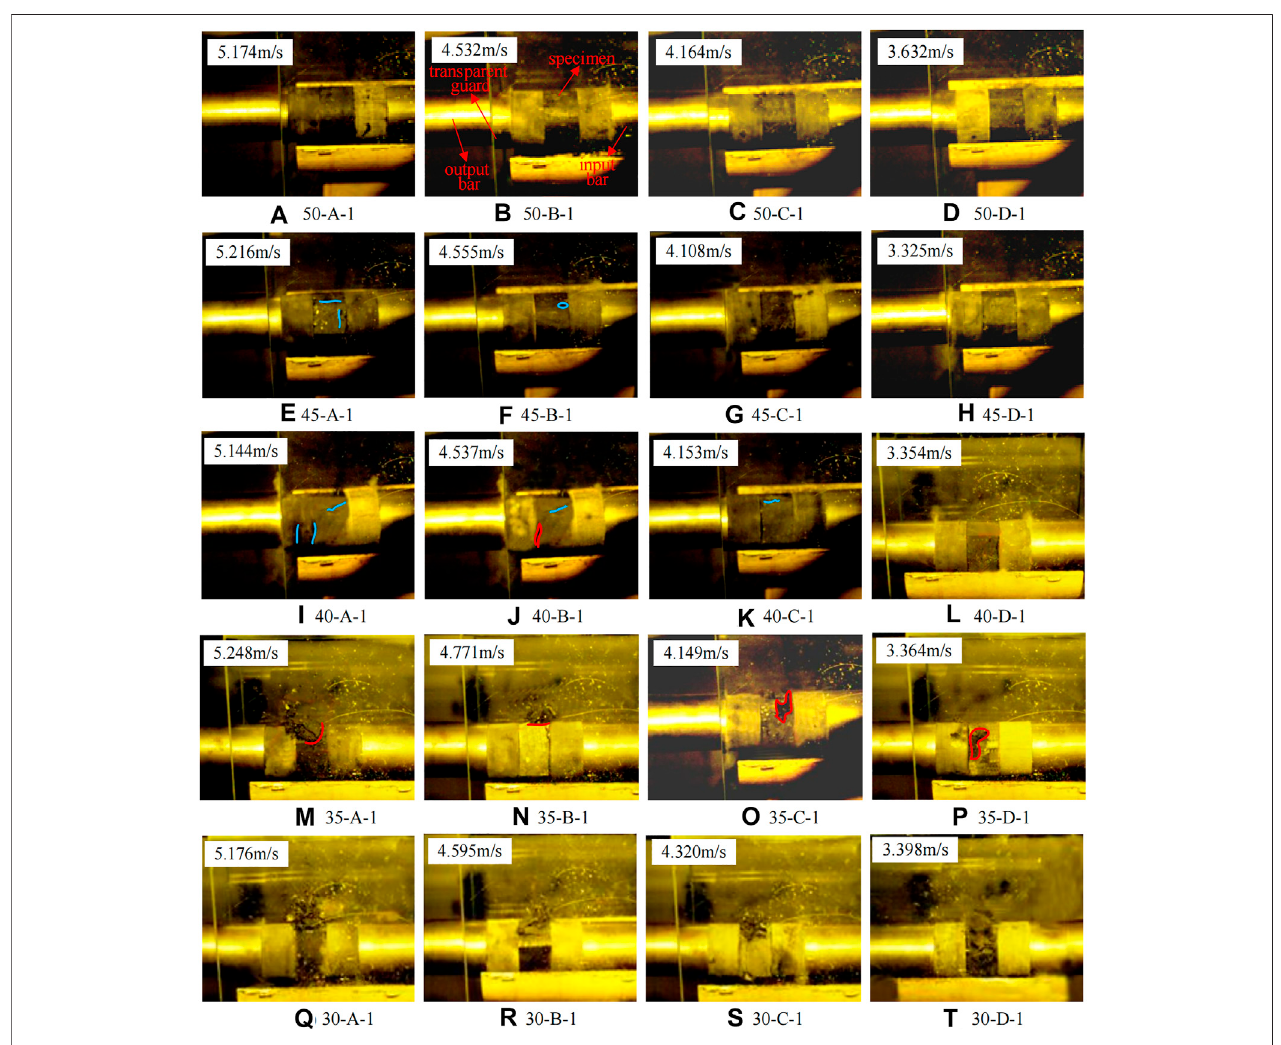
FIGURE 5 | (A – T) Failurepatternsofspecimensunderdifferentdynamicloadswithoutpre-staticload(Inthe fi gure,thebluelineindicatesthepositionofthecrackafterthe failure of the specimen, and the red line represents the boundary of the spalling area of the specimen. The blue and red lines in Figures 10 – 12 also indicate this meaning).